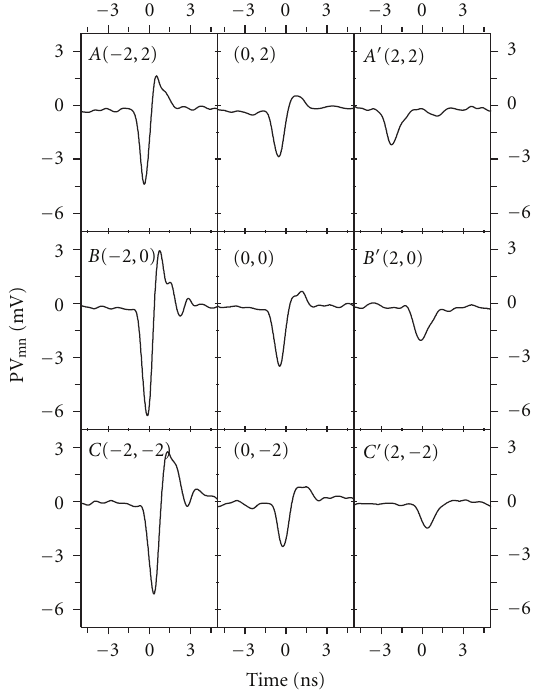
Figure 2: Photovoltaic signals PV mn between m and n electrodes under the irradiation of 1064 nm pulse laser at selected positions of ( − 2, 2), (0, 2), (2, 2), ( − 2, − 2), (0, − 2), and (2, − 2), respectively.